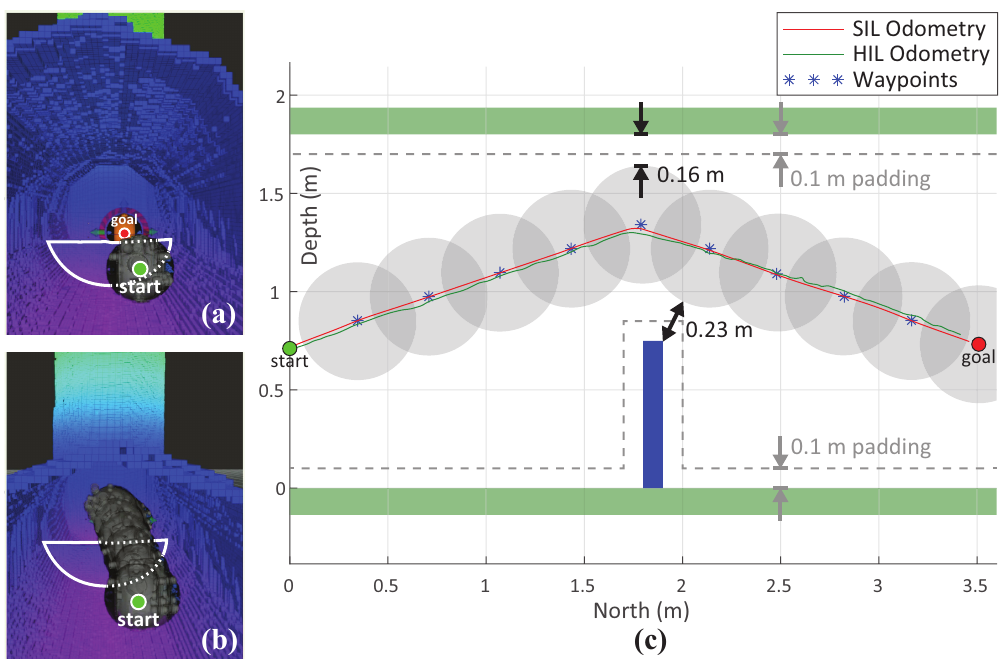
Figure 13. Path planning experiment with environmental restrictions depicted in different views. ( a ) OctoMap of the environment with start and goal position of the robot. ( b ) 3D planned path. ( c ) Side view of the mine tunnel with an obstacle between start and goal position of the robot. Tunnel walls are depicted in green, the obstacle in blue, and gray circles depicts the planned